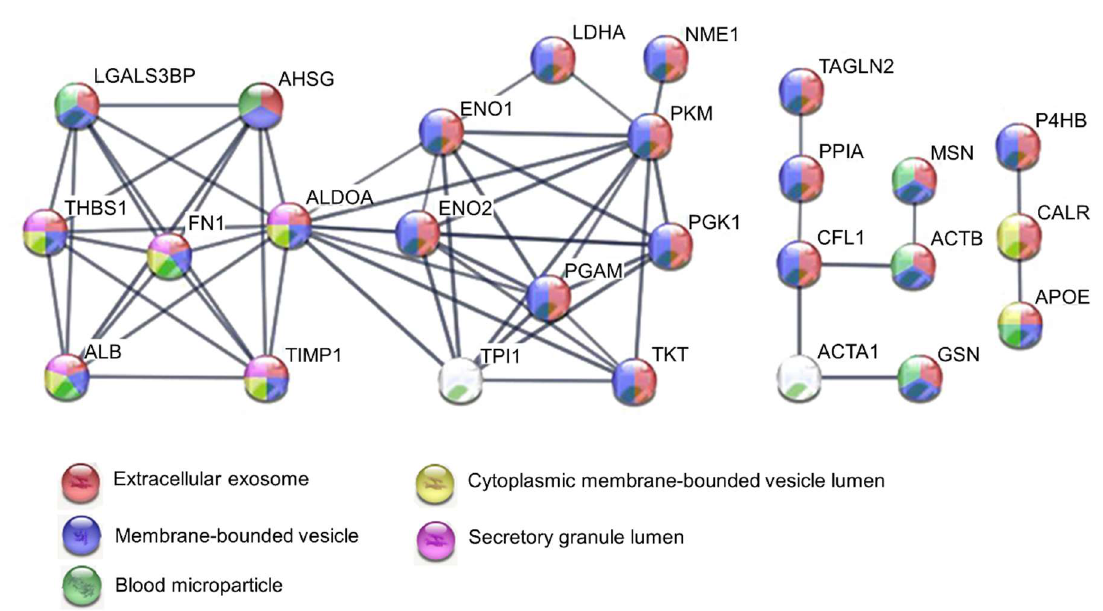
Figure 3. Protein-protein interaction network of 39 secreted proteins enriched in pancreatic ductal adenocarcinoma. Analysis using STRING [101] illustrates potential interactions between secreted proteins with a minimum confidence score of 0.7. Proteins in the interaction network are represented as nodes connected by lines whose thickness reflects a confidence index higher than 0.7. The top five enriched GO terms are represented by the network node colors for each protein: red, extracellular exosome; blue, membrane-bounded vesicle; green, blood microparticle; yellow, cytoplasmic membrane-bounded vesicle lumen; purple, secretory granule lumen. Table 4. Gene Ontology (GO) enrichment analysis of secreted proteins in pancreatic cancer. Cellular Component